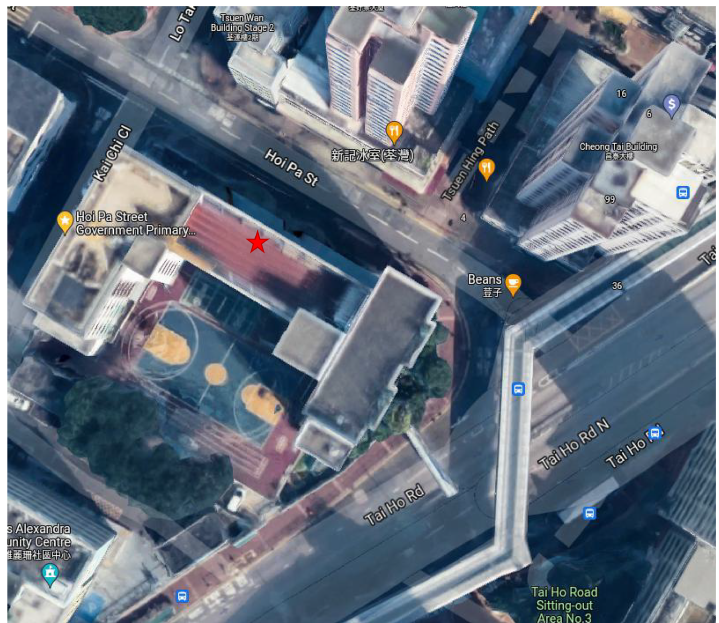
Figure F1. Measurement site in Tsuen Wan, Hong Kong (image taken from © Google Maps). The measurement location is indicated by the red